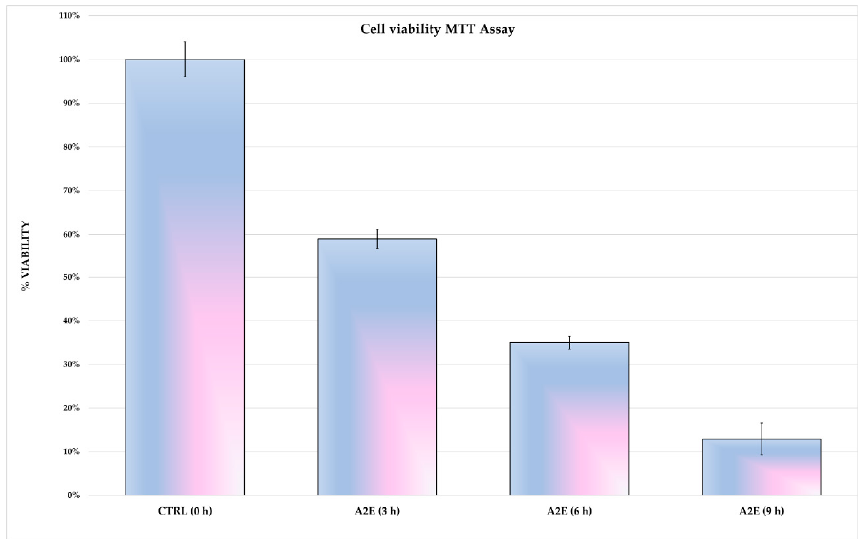
Figure 1. Methylthiazolyldiphenyl-tetrazolium bromide (MTT)-viability assay results. N -retinylidene- N -retinylethanolamine (A2E) had a cytotoxic e ff ect on human retinal pigment epithelium (H-RPE) cells in a time-dependent manner. The viability of untreated (0 h) H-RPE cells and 3, 6 and 9 h A2E-exposed H-RPE cells is expressed as a percentage, as the mean ± SD ( n = 3). Statistical significance was assessed by multiple t-tests ( p -values < 0.05). Due to markedly decreased cell viability at 9 h with A2E, this time point was excluded in further